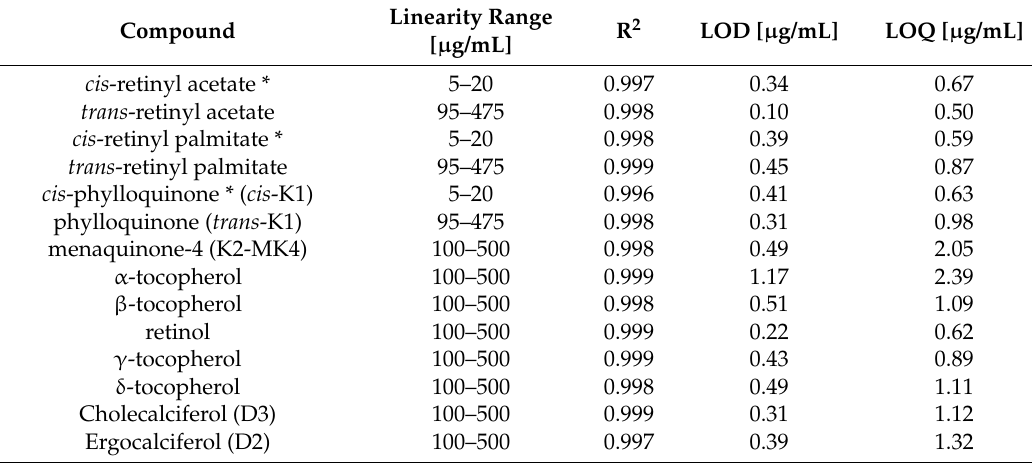
Table 2. Calibration data for the external calibration method for analyzing fat-soluble vitamins with the use of the UPC 2 (ultra performance convergence chromatography)